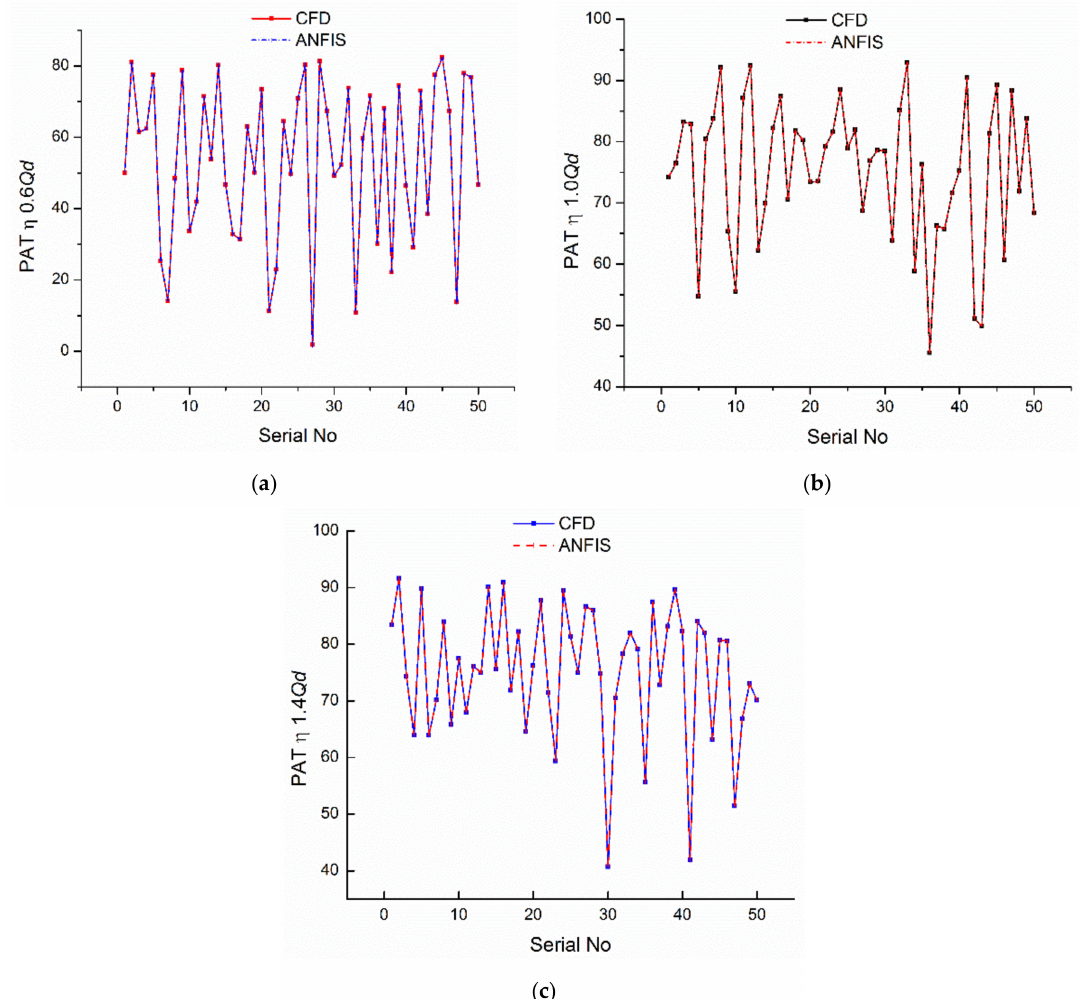
Figure 17. Validation of ANFIS prediction with CFD: ( a ) 0.6 Q d , ( b ) 1.0 Q d, and ( c ) 1.4 Q d.